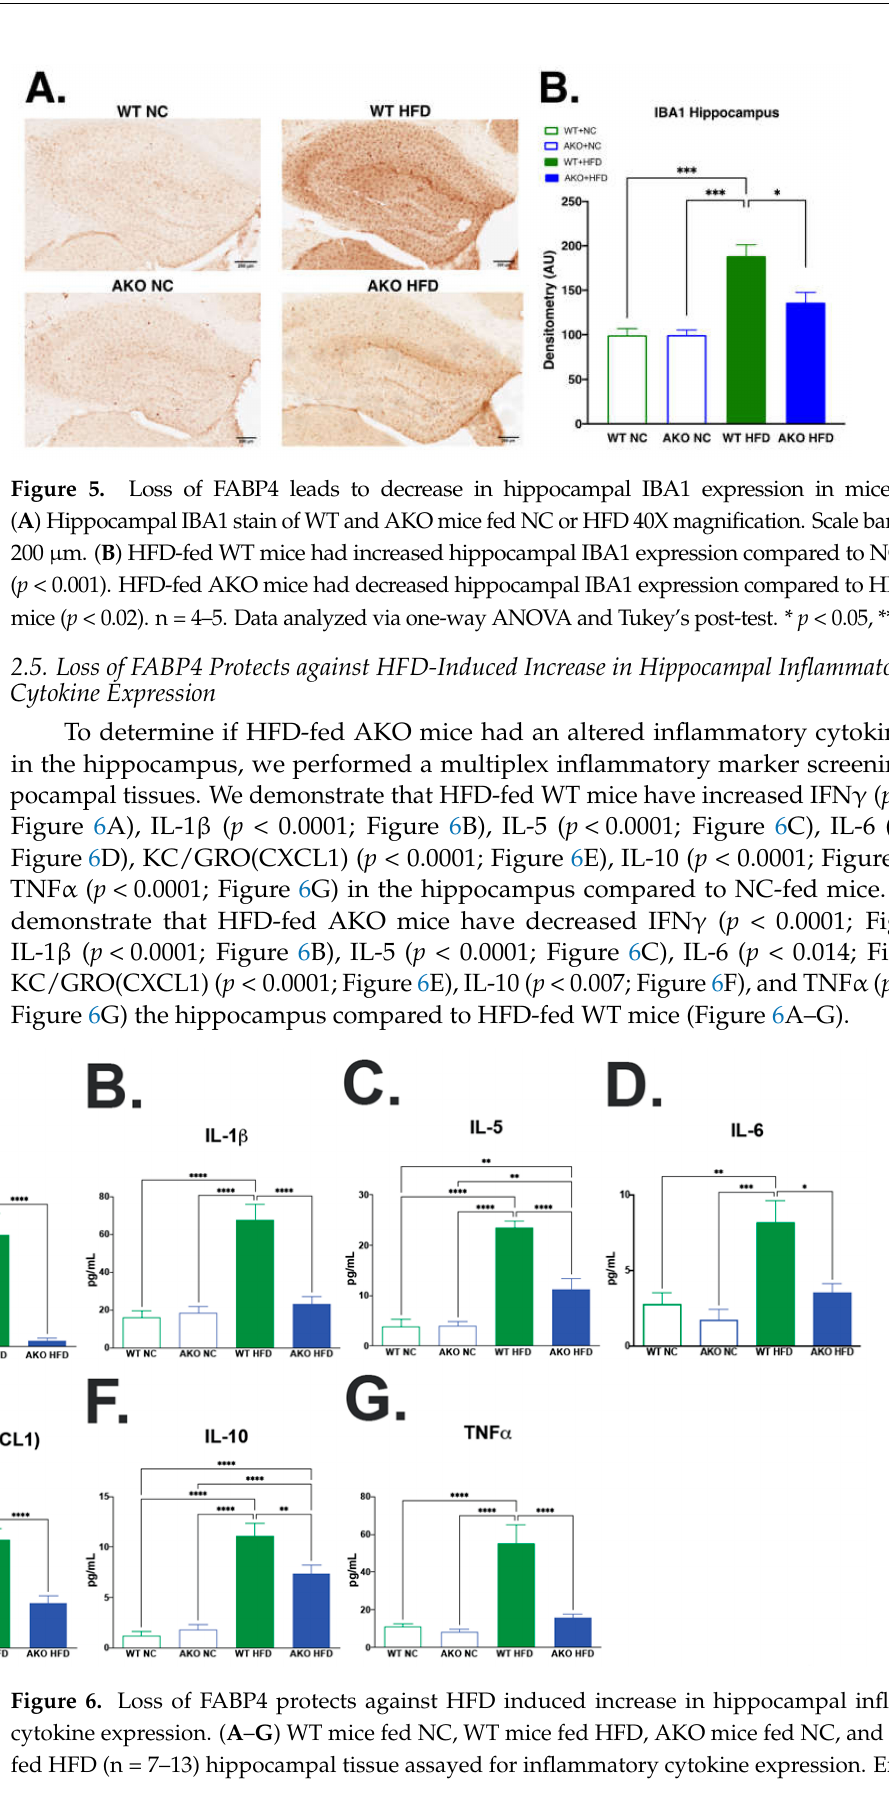
Figure 6. Loss of FABP4 protects against HFD induced increase in hippocampal inflammatory cytokine expression. ( A – G ) WT mice fed NC, WT mice fed HFD, AKO mice fed NC, and AKO mice fed HFD (n = 7–13) hippocampal tissue assayed for inflammatory cytokine expression.